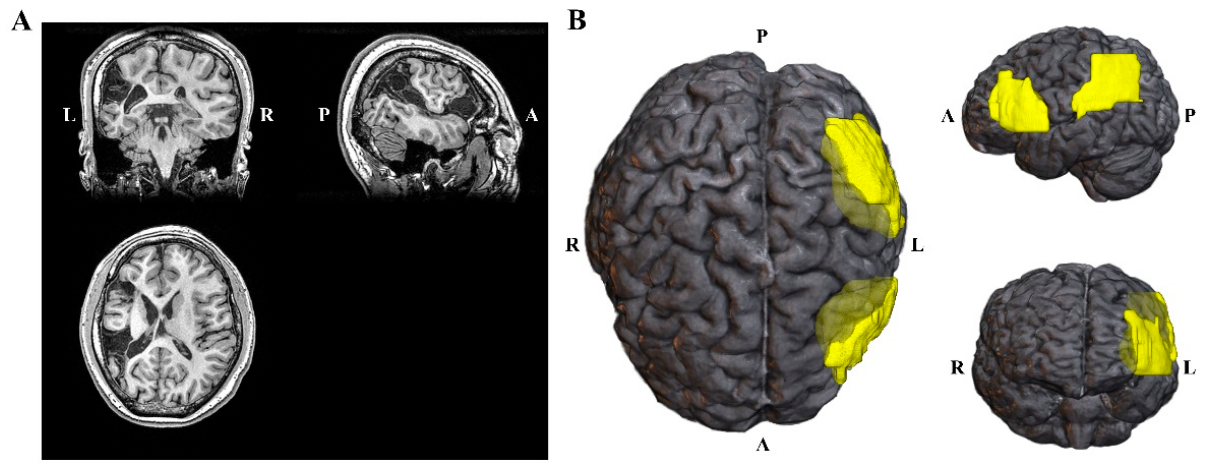
Figure 1. Three-dimensional (3D) MRI image and the locus of brain lesions. ( A ) T1-weighted MR brain images of participant. ( B ) Lesion map of participant, yellow areas represent brain lesions. All clinical procedures were carried out in accordance with the Declaration of